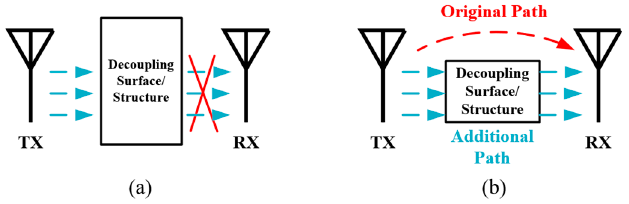
Figure 13. Two kinds of decoupling structure. ( a ) Filter. ( b ) Additional coupling path.